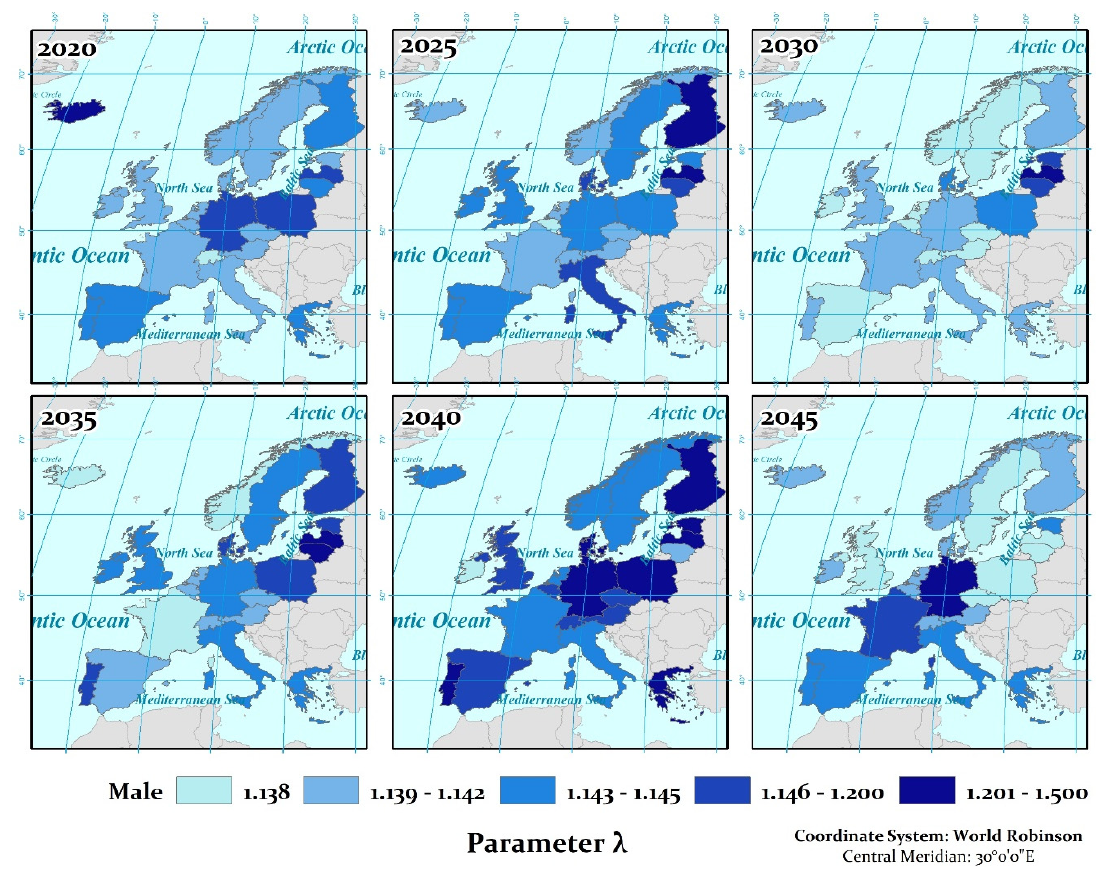
Figure 4. Projected values of random risk factor for the 22 EU countries (parameter λ —male).